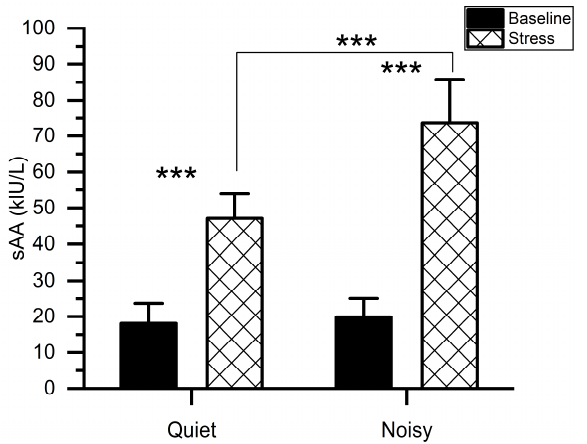
Figure 3. Mean activity of salivary alpha-amylase for stress and baseline at quiet and noisy work- places. The error bars indicate the standard deviations and the stars indicate the significant differ- ences (*** p < 0.001).